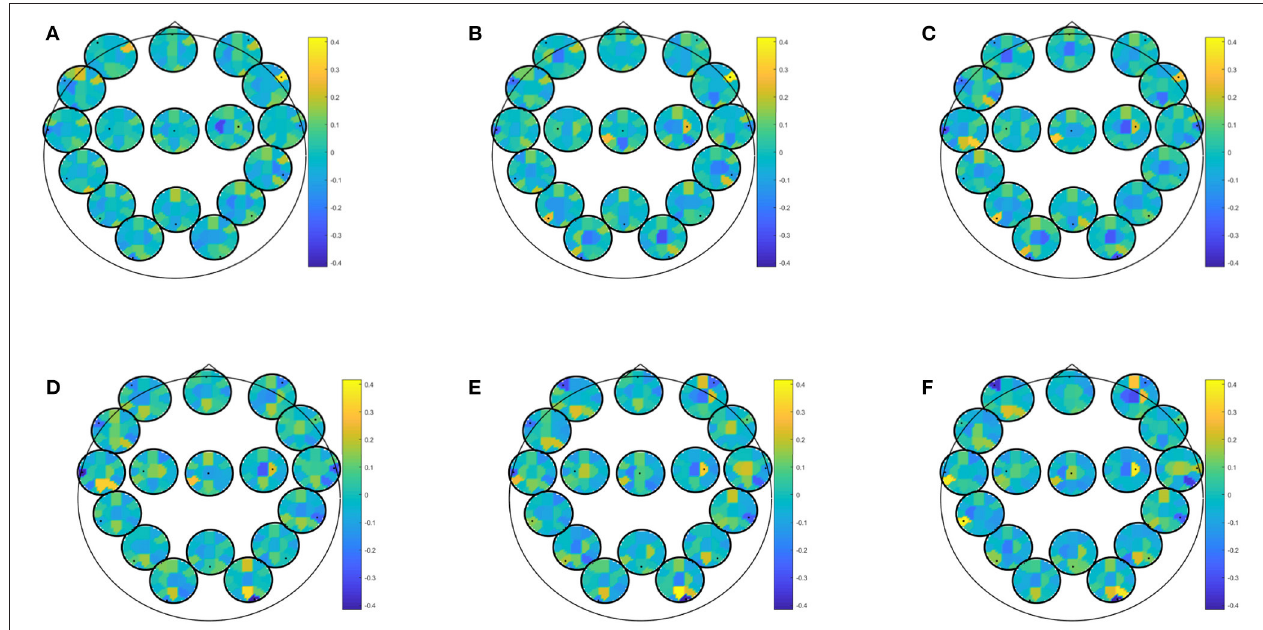
FIGURE 2 | Predictor coefficients β for directed transfer function (DTF) extracted during recognition of positive pictures. Coefficients indicate importance of the feature to the model for prediction of at least moderate depressive symptoms in winter. (A) Delta 1–4 Hz, (B) Theta 5–7 Hz, (C) Alpha 8–12 Hz, (D) Beta 13–20 Hz, (E) Beta 2 21–30 Hz, (F) Gamma 31–48